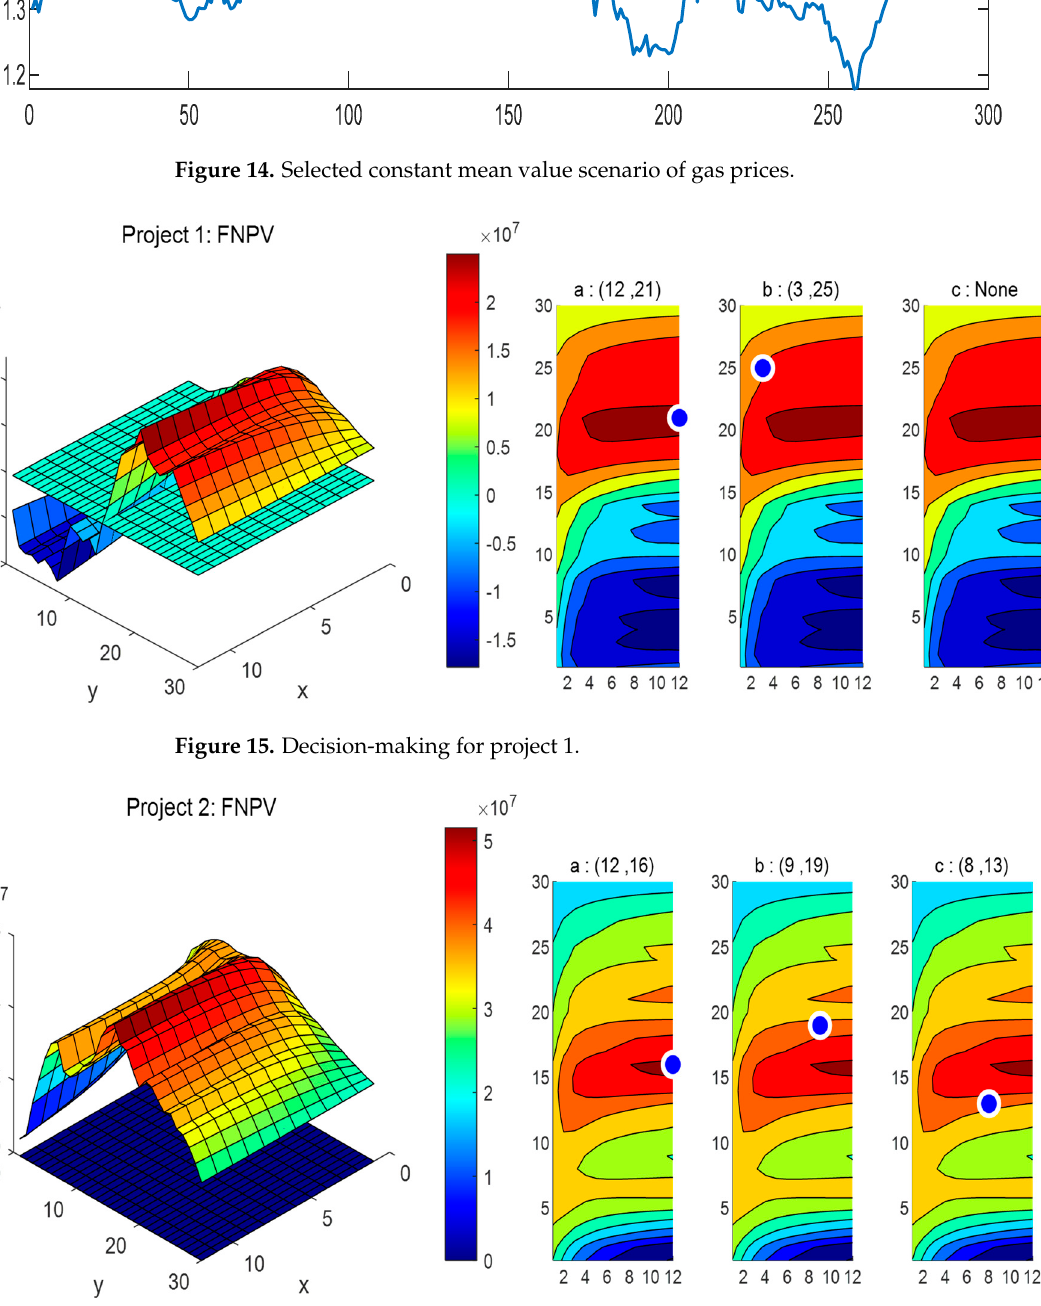
Figure 16. Decision − making for project 2. Figure 16. Decision-making for project